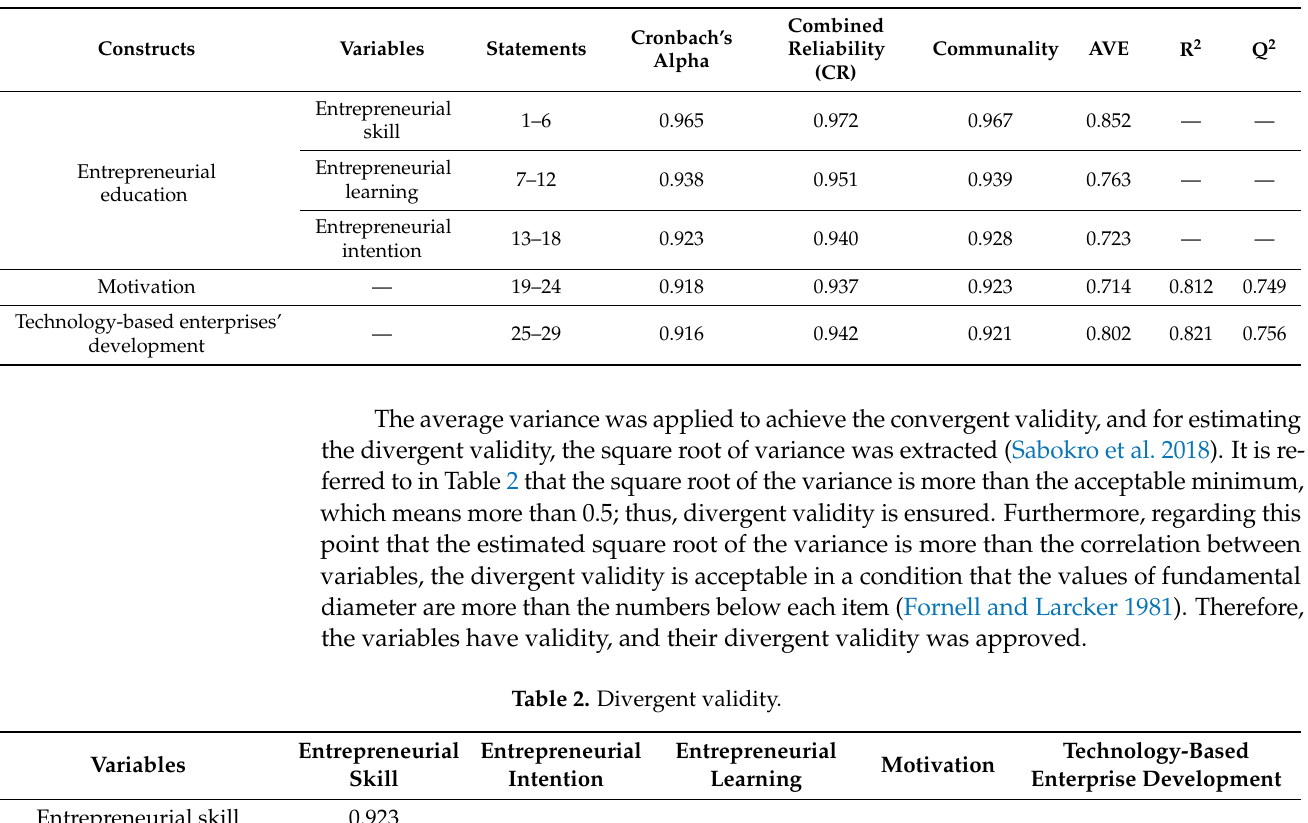
Table 1. AEV, Cronbach’s alpha, and composite reliability.